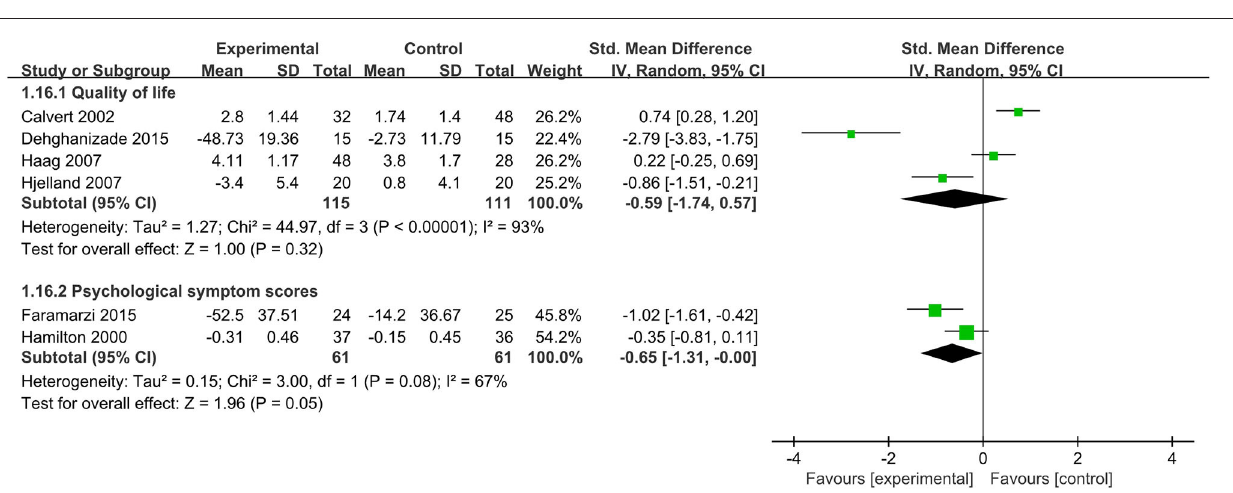
FIGURE 5 | Meta-analysis of the effect of psychological interventions on quality of life and psychological symptom scores. CI, confidence interval.